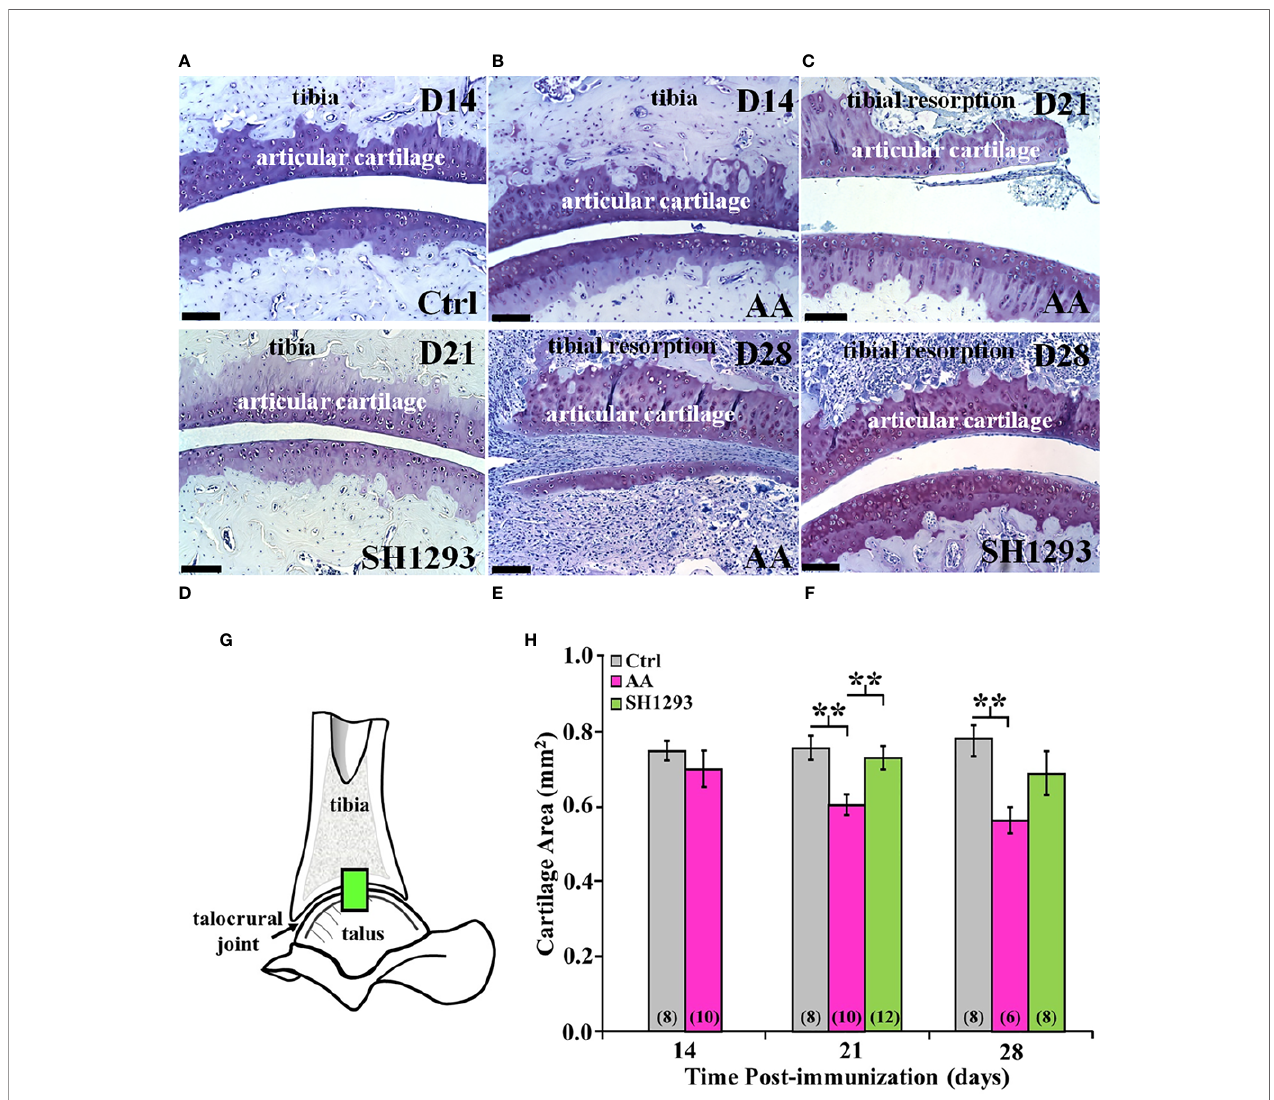
FIGURE 8 | SH1293 Spared Articular Cartilage Resorption in AA Rats. Resorption of articular cartilage and subchondral bone were assessed at the apex of the distal tibial concavity. (A – F) Toluidine blue-stained images from the distal tibia and proximal talus of Ctrl, AA, and SH1293 rats revealed striking differences in articular cartilage and subchondral bone between experimental groups across time. Calibration bars = 100 µm. (A) In Ctrl rats, articular cartilage and subchondral bone were normal. (B) In AA rats at D14, AA induced resorption of the subchondral bone, but the articular cartilage appeared normal. (C) In AA rats at D21, subchondral bone was resorbed and articular cartilage lost. (D) At D21, there was no discernable changes in the articular cartilage or subchondral bone in SH1293-treated rats. (E) In AA rats, resorption of both the subchondral bone and articular cartilage was severe in the distal tibial concavity by D28. (F) The sparing effects of SH1293 observed on D21 in SH1293-treated rats on cartilage and subchondral bone resorption were lost by D28. (G, H) Morphometric analysis of cartilage area (H) was completed in a zone within the talocrural joint, as illustrated in the diagram of the talocrural joint (G) . (H) Cartilage area did not differ between Ctrl and AA rats at D14. However, by D21, AA rats had signi fi cantly reduced cartilage area compared with both the Ctrl ( ** p < 0.01) and SH1293 ( ** p < 0.01) groups. At D28, cartilage area in AA rats was less than that observed for Ctrl rats ( ** p < 0.01), but cartilage area did not differ between SH1293 and Ctrl rats. The n ’ s per group are indicated in parentheses at the base of each